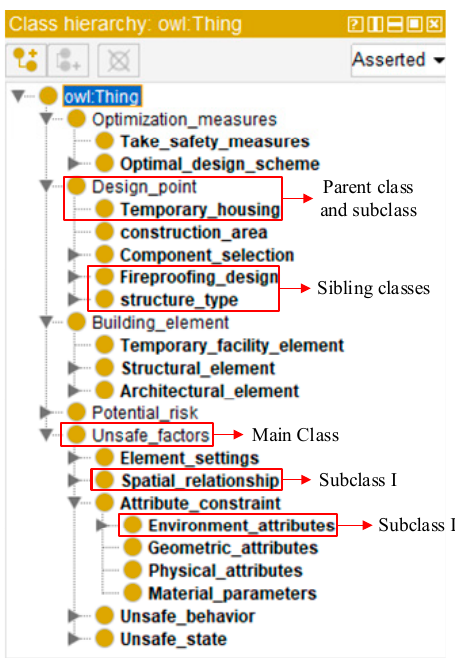
Figure 12. The class hierarchy of DFS ontology.